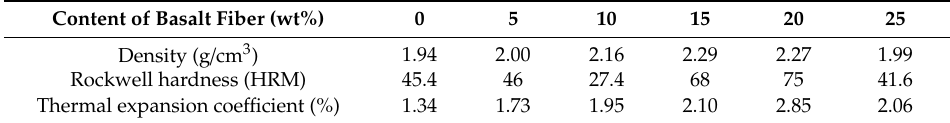
Table 3. Physical properties of the composites.